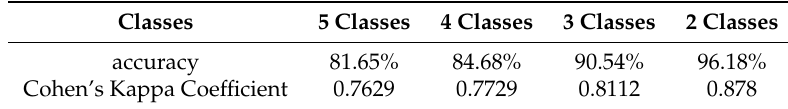
Table 28. The classification accuracy and Cohen’s Kappa Coefficient of 2–5 class sleep classification on ISRUC3 database.